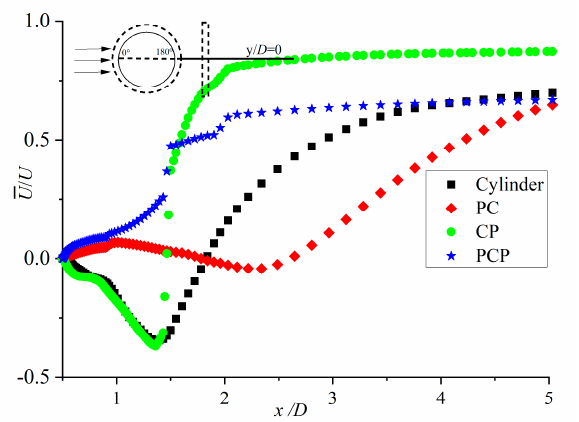
Figure 15. A comparison of time-averaged stream wise velocities normalized with U along the wake centerline.